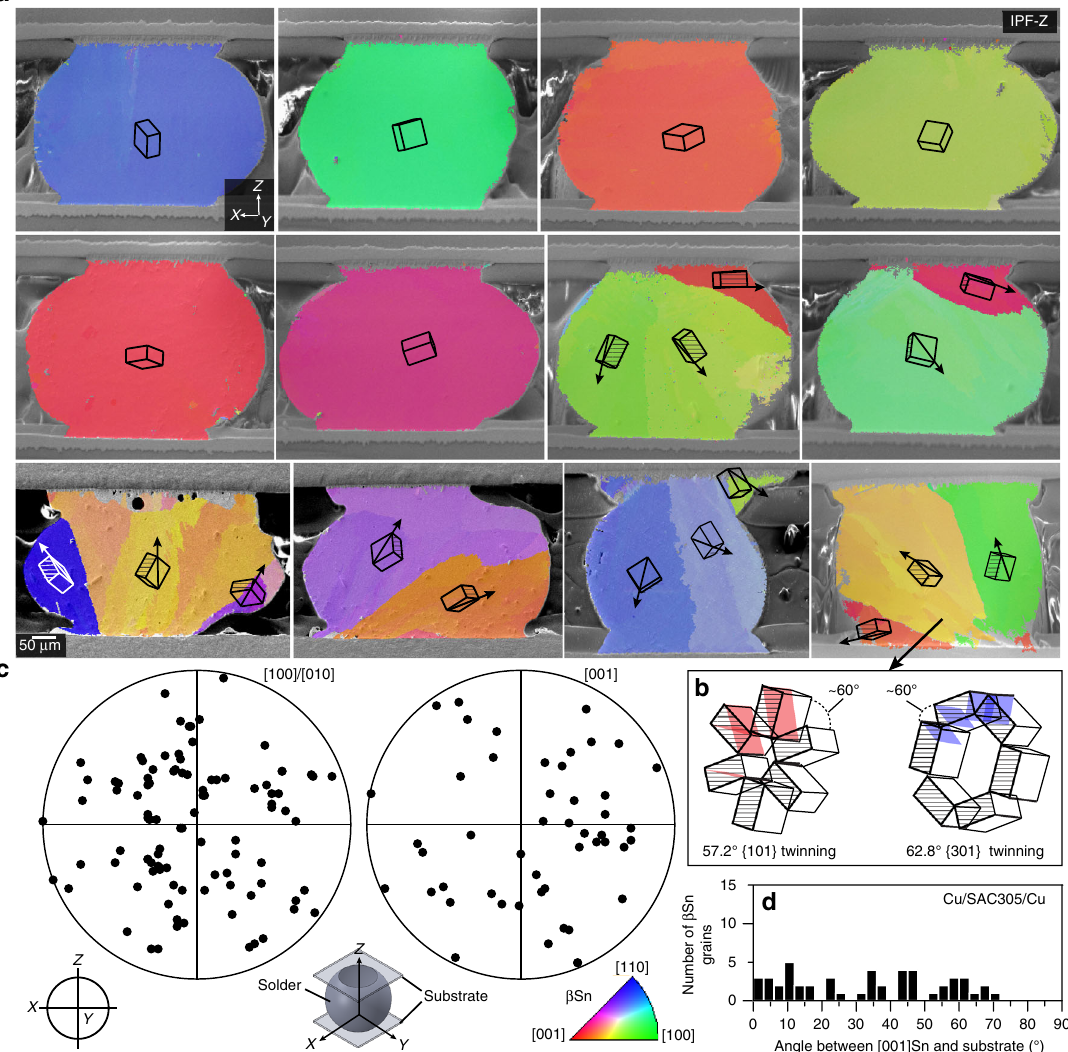
Fig. 1 Typical β Sn microstructures and orientations in Cu/Sn-3Ag-0.5Cu/Cu joints. a EBSD inverse pole fi gure maps (IPF-Z) of 12 Cu/Sn-3Ag-0.5Cu/Cu joints that were cooled from ~240 °C in either a DSC at 0.33 K s − 1 or an industrial re fl ow oven at 1 – 5 K s − 1 . Wireframe unit cells are superimposed on each main orientation using the mean Euler angles of that grain. All joints with multiple grains are solidi fi cation twins with a common < 100 > axis and common {100} plane indicated by cross-hatching on the unit cells. b Cyclic twinning in one joint shown by translating the unit cells into the {101} and {301} cyclic twin con fi gurations 35 with the parallel {100} planes and {101} and {301} twinning planes shaded. c < 100 > and < 001 > pole fi gures showing the highly variable β Sn grain orientations in 33 joints. d The distribution of angles between [001]Sn of all β Sn grains and the plane of the Cu